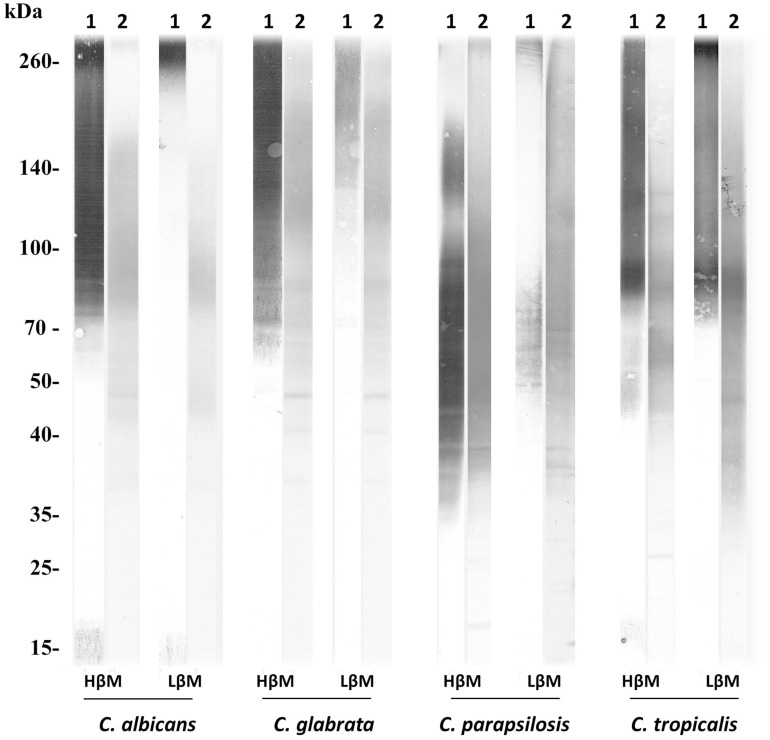
Representative patterns of α- and β-Man expression on glycoconjugates from the four main Candida species (HβM, high β-Man profile; LβM, low β-Man profile). Glycoconjugates appear as heterogeneous smears reflecting the glycosylation level of the molecules.